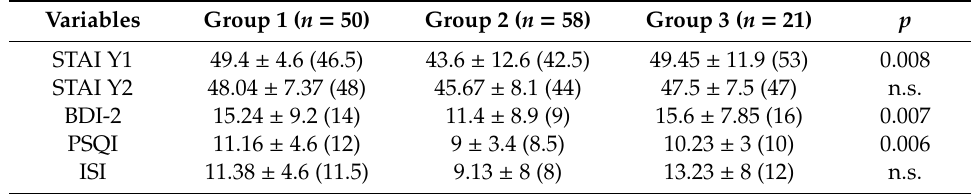
Table 2. Mean, standard deviation and median psychopathological, and sleep questionnaires’ total scores of the study sample.